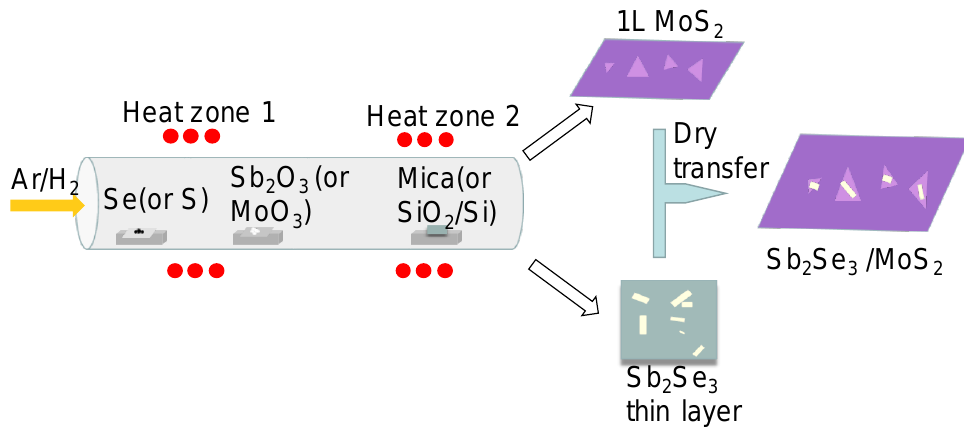
Figure 1. Schematic of the preparation of Sb 2 Se 3 /1L-MoS 2 HJ samples.